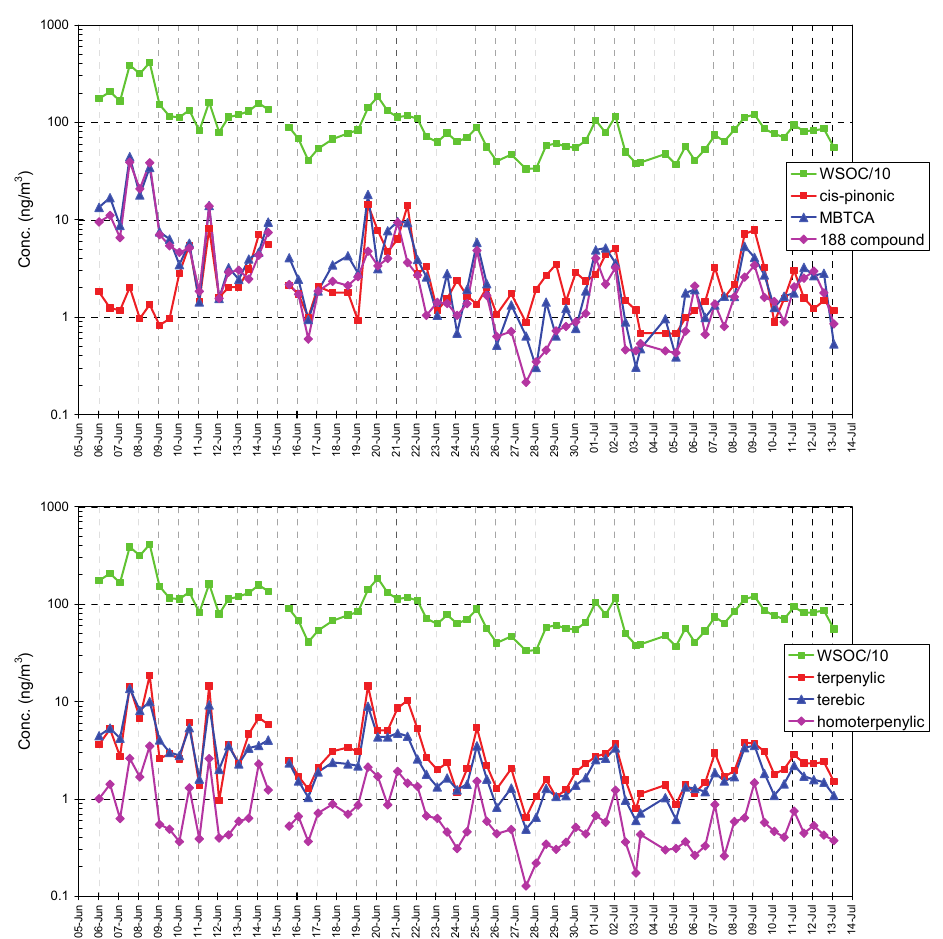
Fig. 4. Time series for (top): cis -pinonic acid, MBTCA, and the unknown MW 188 terpenoic acid; and (bottom) the lactone-containing terpenoic acids, terpenylic acid, terebic acid, and homoterpenylic acid, as derived from the PM 2 . 5 front filters of the HVDS, for the 2007 summer campaign in Brasschaat. For comparison, the time series of WSOC, which is a proxy for SOA, is also presented, and for clarity it is repeated in each of the graphs. Note that all terpenoic acids shown mainly peak during day-time during the first 10 sampling days.